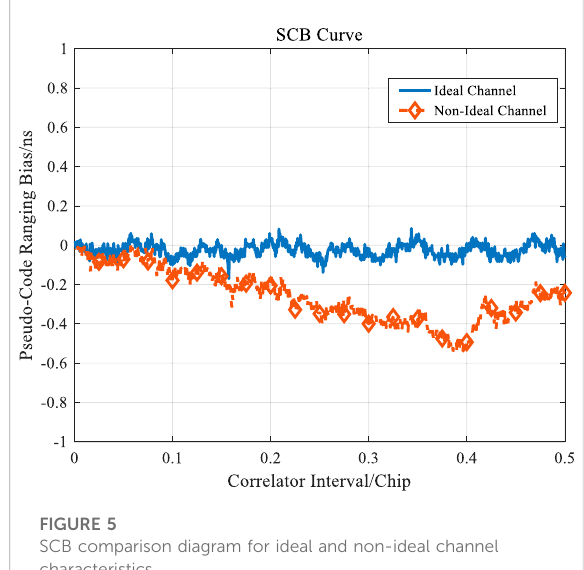
FIGURE 5 SCB comparison diagram for ideal and non-ideal channel characteristics.